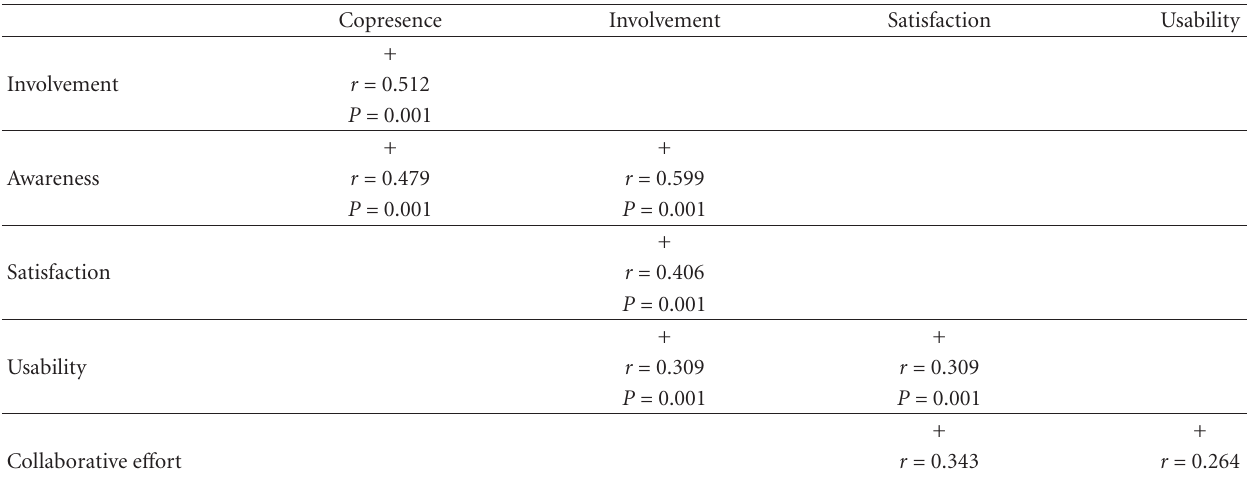
Table 2: Person’s correlations between variables (legend: + = (positively) significant on 1% confidence level).